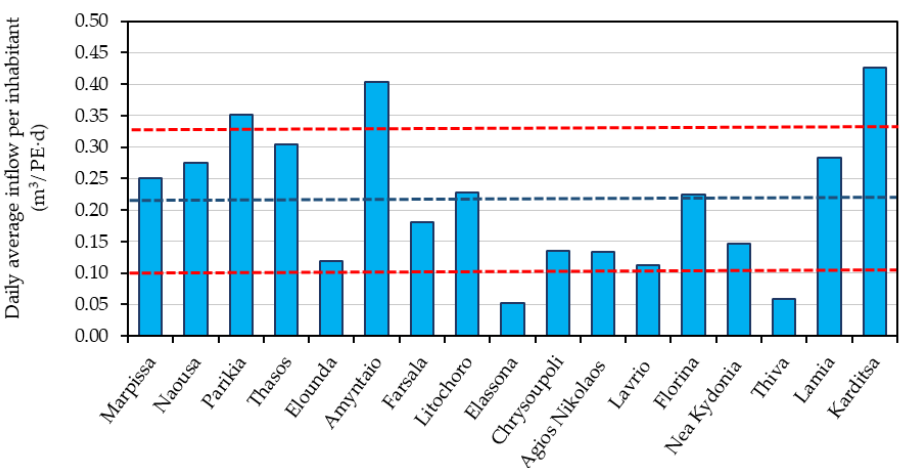
Figure 3. Average daily incoming flow per inhabitant (m 3 /PE·d) (blue bars), with average value (dashed blue line) and standard deviation (dashed red lines) for the 17 examined WWTPs.